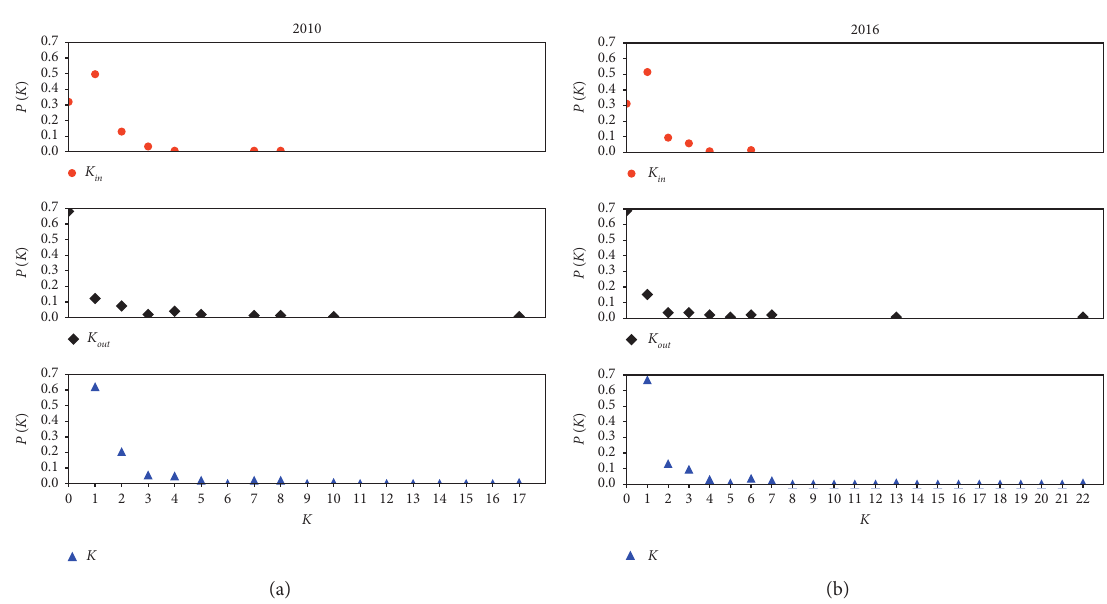
Figure 6: The in-degree, out-degree, and degree distributions of the global crude oil trade network after optimization: (a) 2010; (b)